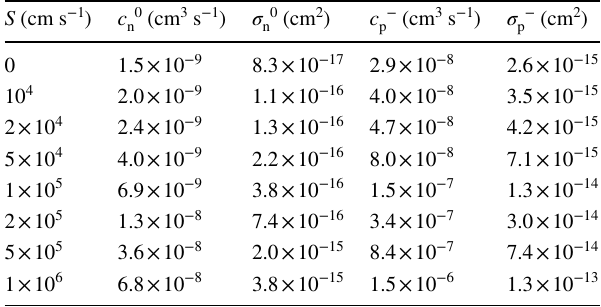
Table 1 Dependence of the electron capture constant c n0 and the electron capture cross section σ n0 by the neutral color center and the hole capture constant c p− and hole capture cross section σ p− by the negatively charged color center on the surface recombination velocity S used in the numerical